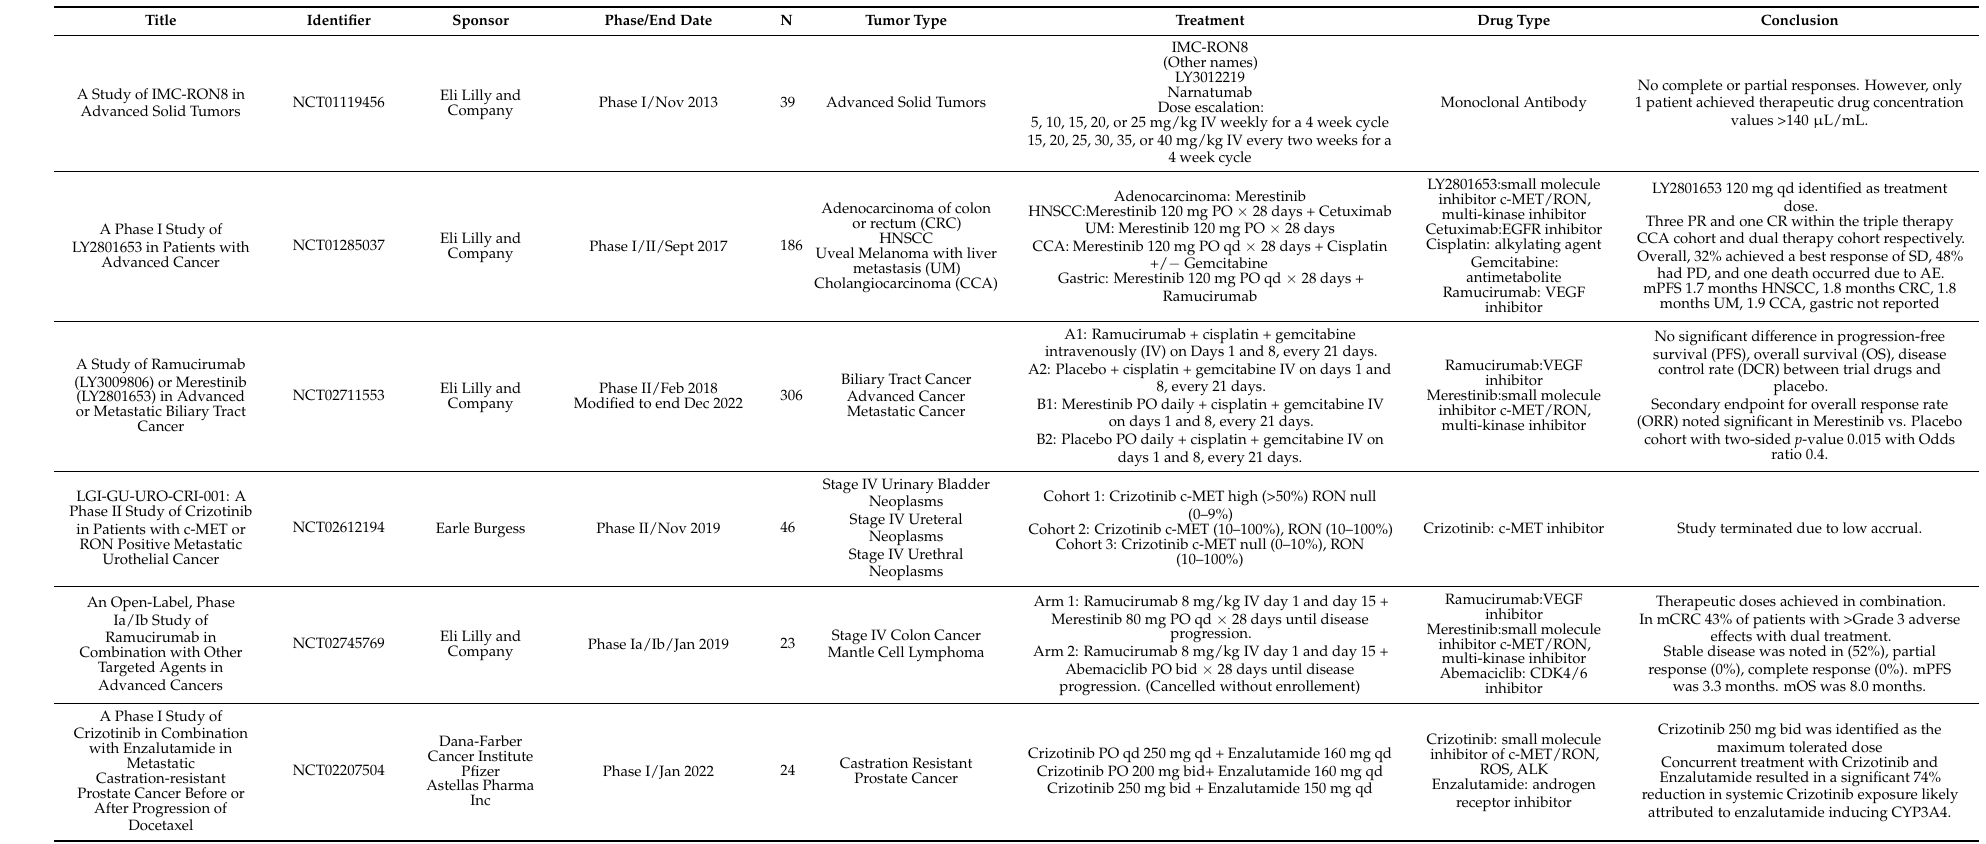
Table 1. Clinical